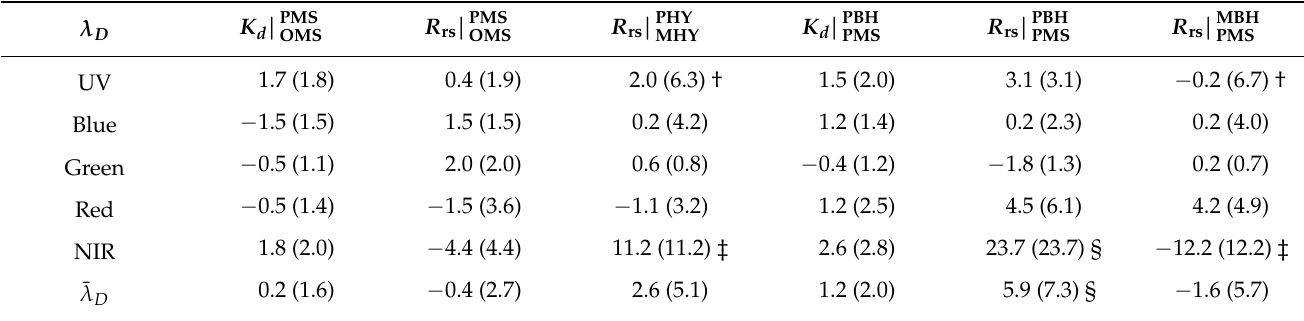
Table 3. The ψ and φ comparison statistics in percent following Table 1 for two detector systems built into a C-PHIRE radiometer based on higher-level data products obtained from field